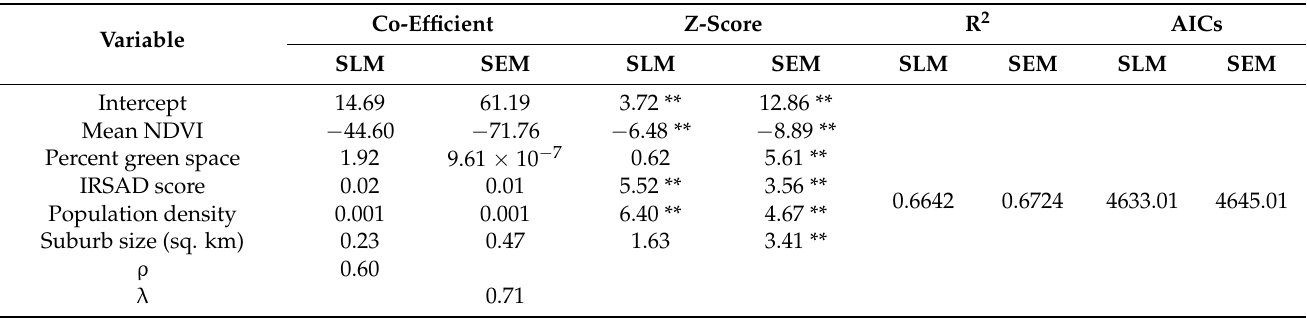
Table 3. Summary statistics of spatial lag and spatial error